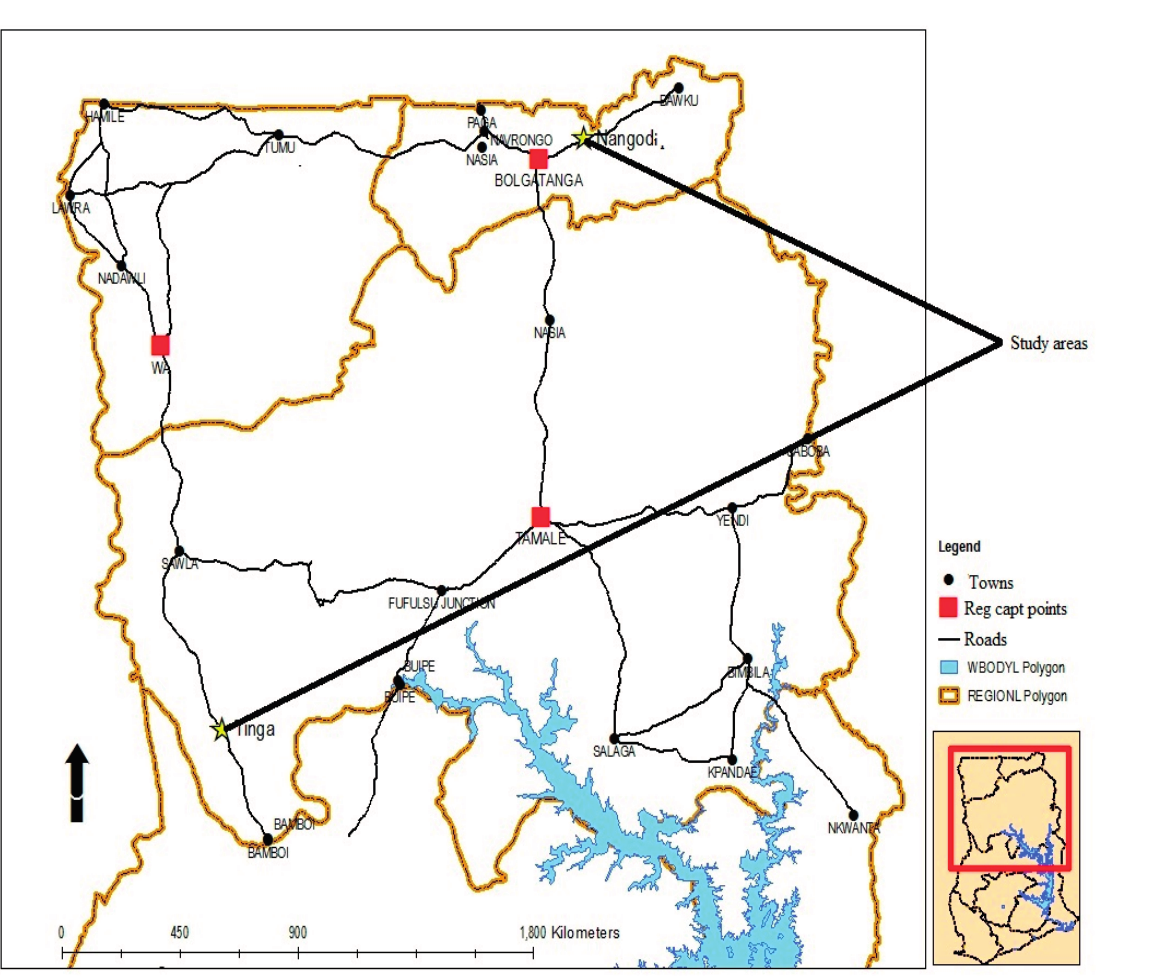
Figure 1. Map of northern Ghana showing Tinga and Nangodi